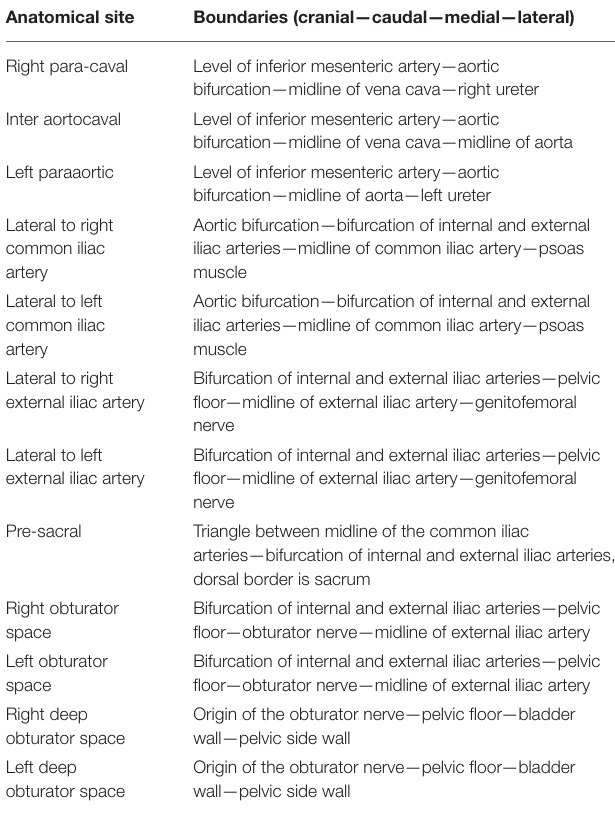
TABLE 2 | Description of anatomical fields for extended PLND by Leissner et al. Anatomical